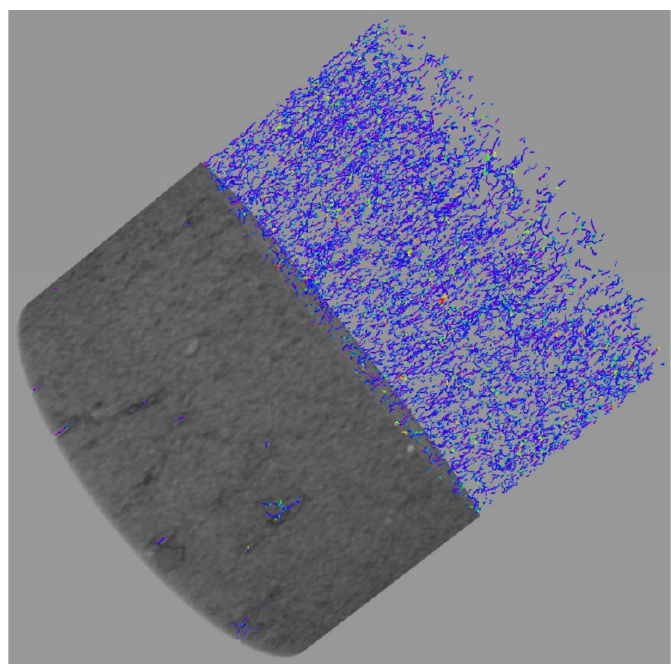
Figure 4. A dense graph of pores for the same sample shown in Figure 3, showing only the connec- tions (shortest to longest: purple, blue, green, yellow, orange, red). Since all individual pixels in connections are shown, the pathways are depicted in more detail than in the sparse graph in Figure 3,